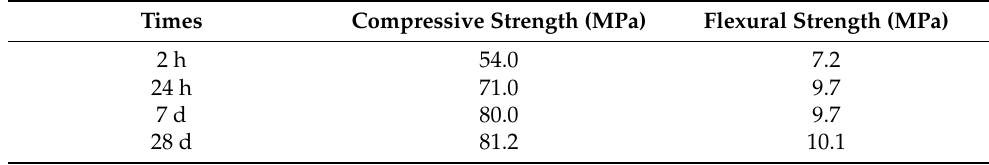
Table 1. Mechanical properties of UR50.